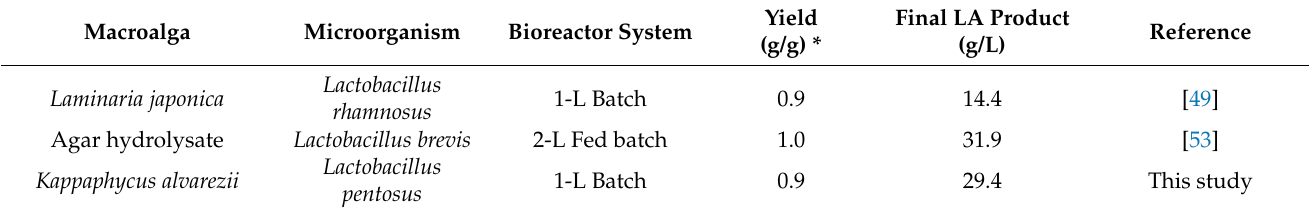
Table 9. Bioreactor scale production of lactic acid from seaweed hydrolysates reported in